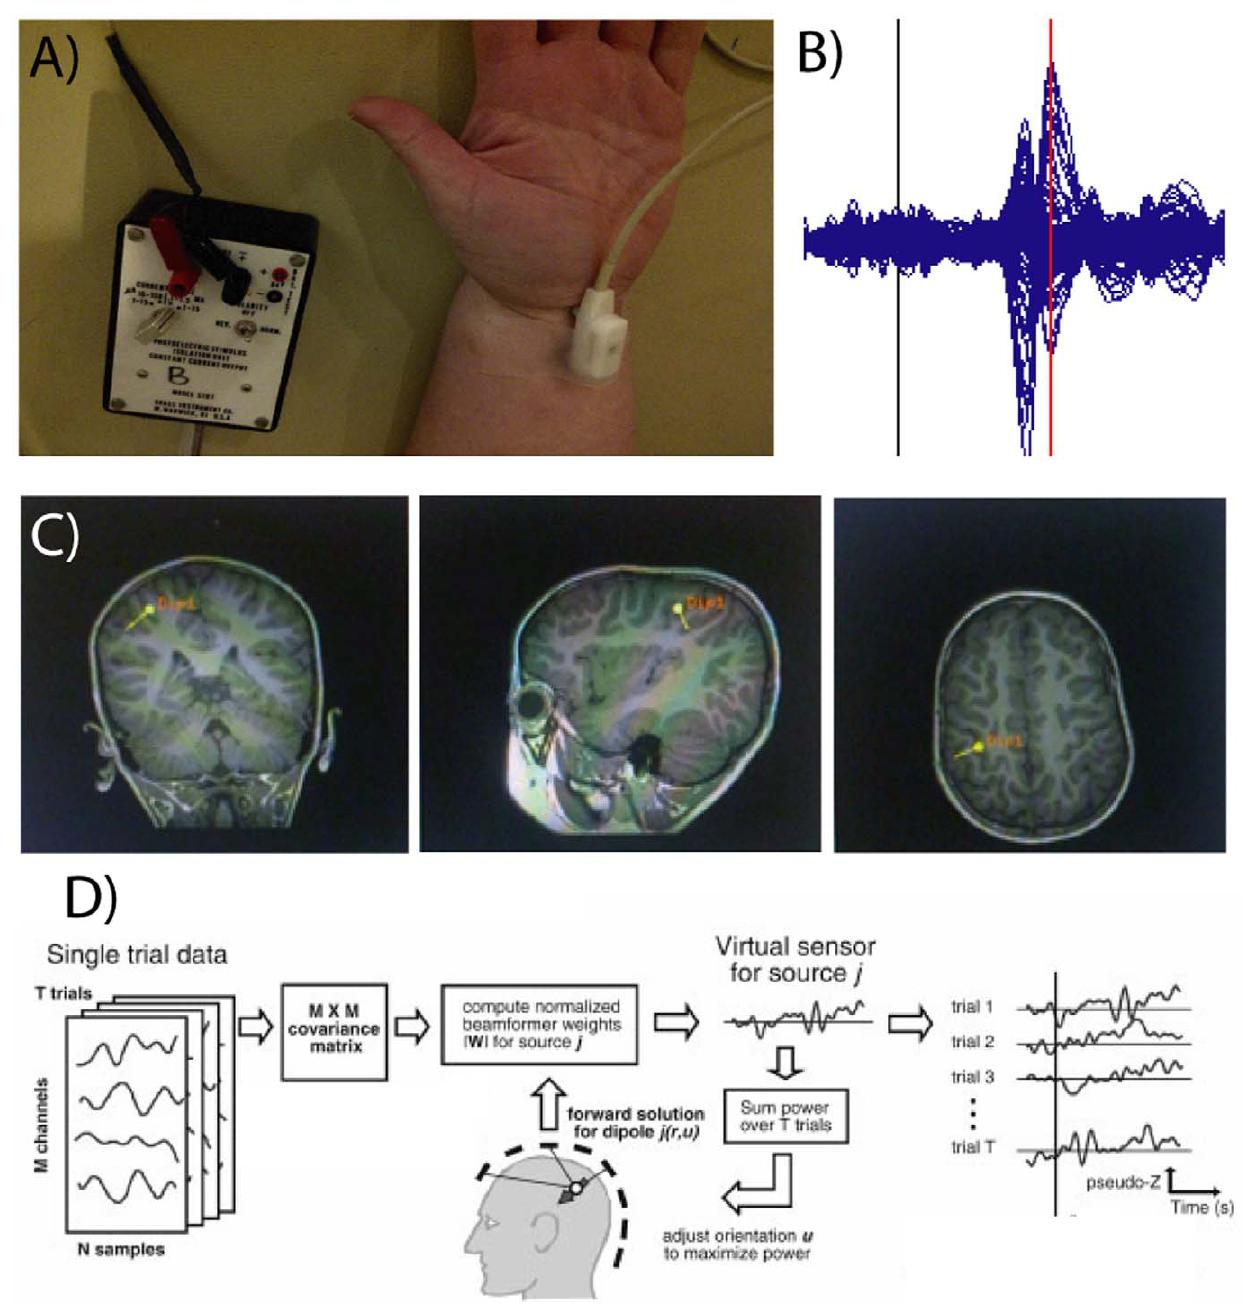
Figure 1. Localization of Rolandic cortex using MEG. Electrical stimulation of the left median nerve (A) produces a high frequency ( . 30 Hz) response first from right somatosensory cortex, followed by a response from right Rolandic cortex (B); the black line indicates stimulation onset and the red line marks the peak of the functional response from Rolandic cortex. Fitting a single dipole to this second peak reveals a posterior-oriented generator which reliably localizes right Rolandic cortex (C; images in radiological perspective). Using coordinates obtained in this manner, we used beamformer analysis to reconstruct the time series of broadband activity from Rolandic cortex on each trial (D, adapted with permission from Cheyne et al., 2006). doi:10.1371/journal.pone.0054943.g001 a weighted sum of sensor recordings in which activity at all other to maximize power for the reconstructed signal for all trials, and locations is maximally attenuated without any power change at the broadband single-trial data are then extracted and normalized by ffiffiffiffiffiffiffi Hz p estimated noise (3 fT/ ), resulting in pseudo-Z values [31]. reconstructed source location [30]. The entire single-trial epoch length was used to estimate data covariance after band-pass filtering (1–300 Hz). The beamformer weights are then derived from the covariance matrix. Source orientation is then optimized